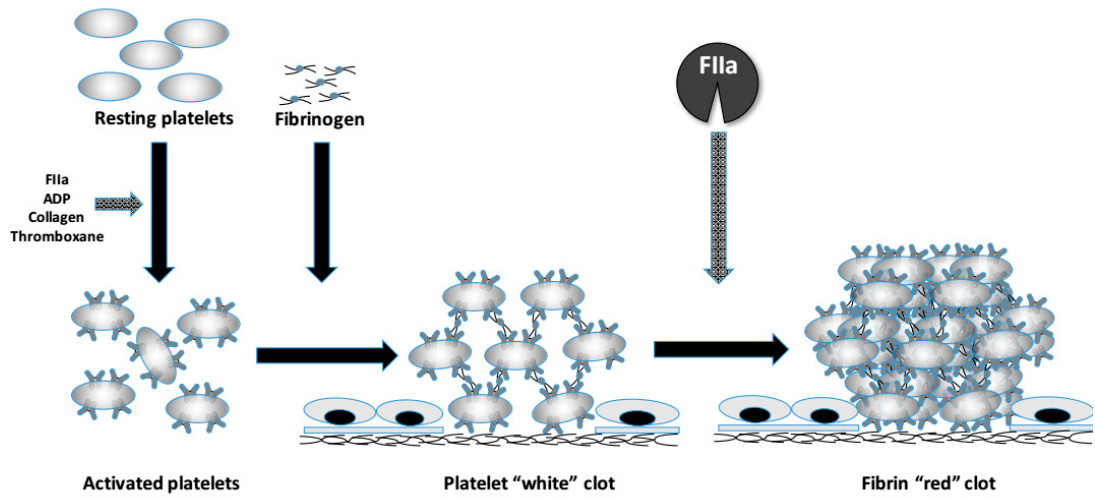
Figure 1. A sketch representing the physiologic role of fibrinogen in the clot formation. The fibrinogen molecule links activated platelets together (white clot) through the alphaIIb–beta3integrin that serves as the fibrinogen receptor. In addition, it is transformed in fibrin by the action of activated thrombin (FIIa), which further stabilizes the fibrin clot by activating FXIII.